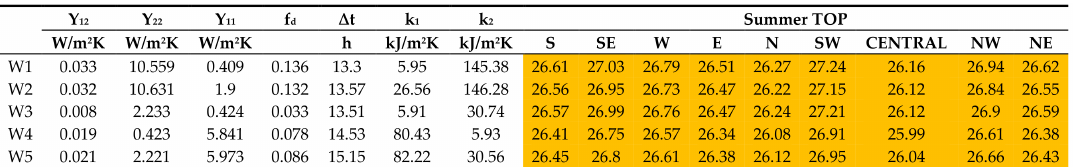
Table 11. TOP analysis for the Combo 17.